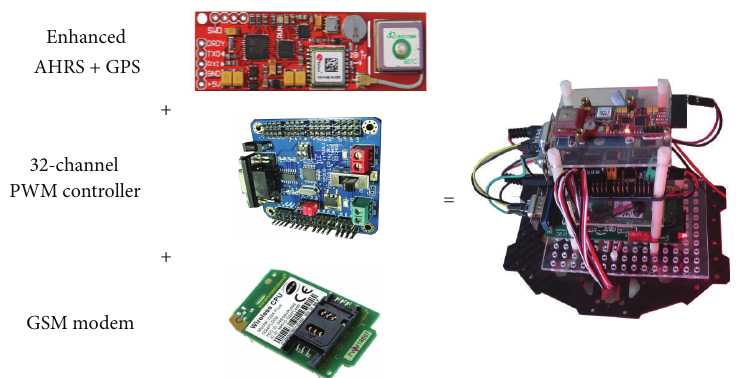
Figure 4: Integrated airborne system structured layers.